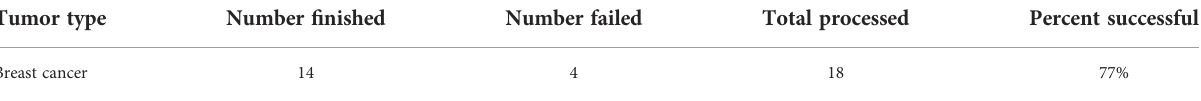
TABLE 1 Success of primary breast cancer cells generation. Tumor